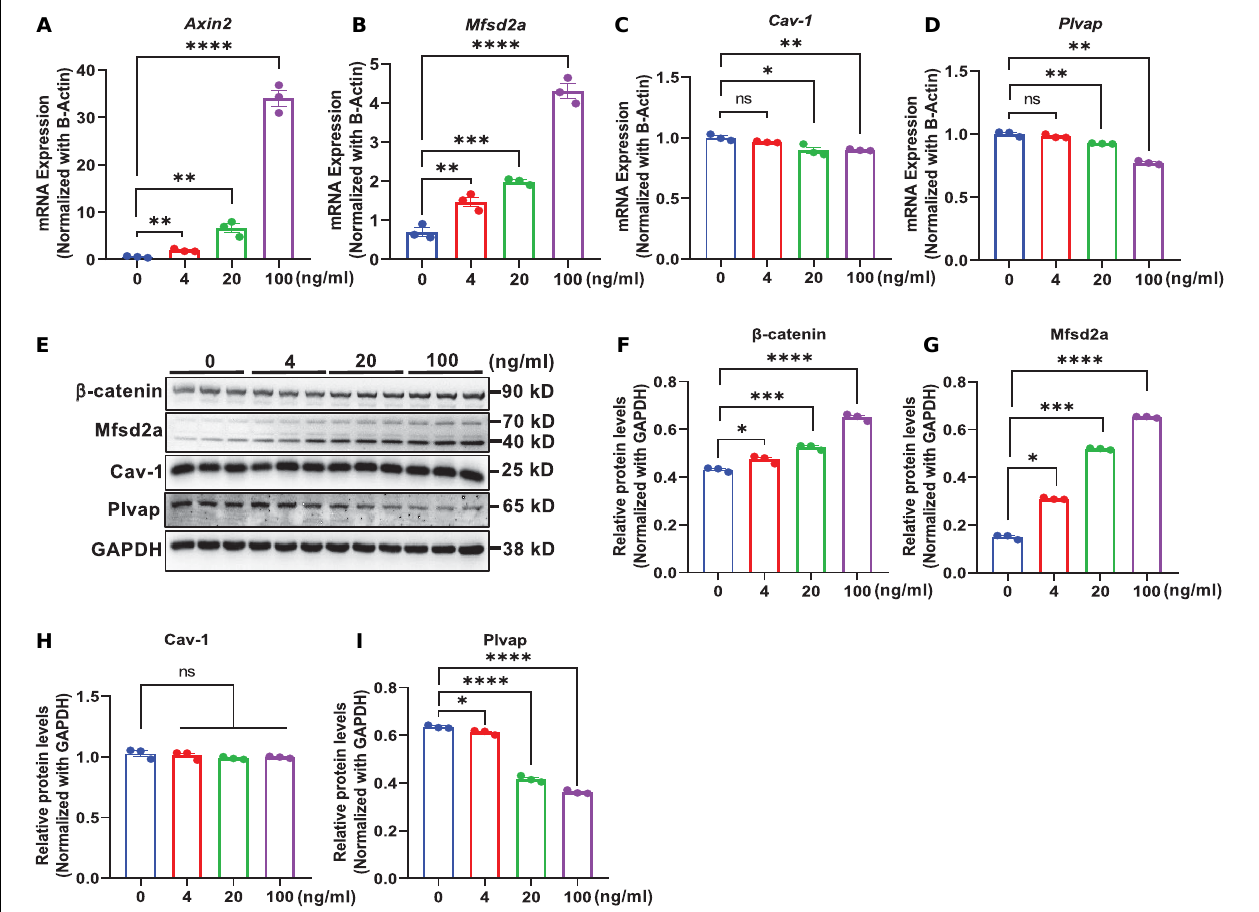
FIGURE 5 | Wnt protein-induced activation of β -catenin signaling regulates transcytosis-related genes in brain endothelial cells. bEnd.3 cells were incubated with recombinant Wnt3a protein (0, 4, 20, and 100 ng/ml) for 24 h and then subjected to various measurements. (A–D) qRT-PCR measurement of the mRNA levels of Axin2 , Mfsd2a , Cav-1 , and Plvap normalized with that of β -actin . (E) Western blot measurement of β -catenin, Mfsd2a, Cav-1, and Plvap. (F–I) Relative protein levels of β -catenin, Mfsd2a, Cav-1, and Plvap normalized with that of GAPDH. Data are mean ± SD. n = 3 per group. ns = not significant, P > 0.05, ∗ P ≤